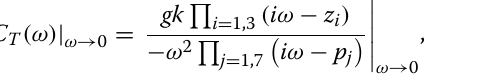
Pressure source model